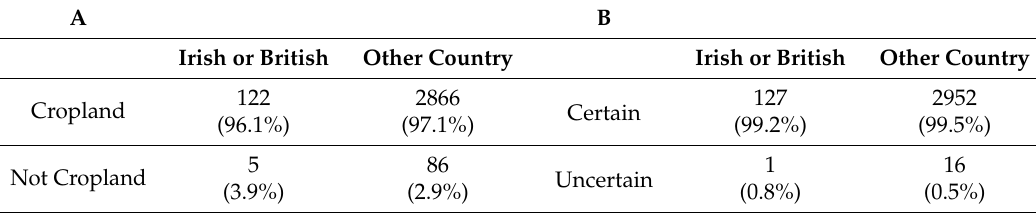
Table 2. Ratings of a subset of non-cropland images in Britain and Ireland as performed by Irish and British participants and participants from other countries. These images were particularly difficult as they contained subdivided pastures that looked like cropland to most volunteers. ( A ) The frequency of rating these images as cropland or non-cropland as a function of country of origin; and ( B ) the frequency of rating these images or expressing uncertainty by using the ‘maybe’ response as a function of country of origin. Note that all responses in Table 2A fall into the ‘certain’ line of Table 2B. The percentage values in parentheses are the proportion of values in a column that were rated in a certain way; for example, in ( A ), 96.1% of the responses by Irish/British participants were that the images were cropland. In both cases, differences between Irish/British players and the general population were not statistically